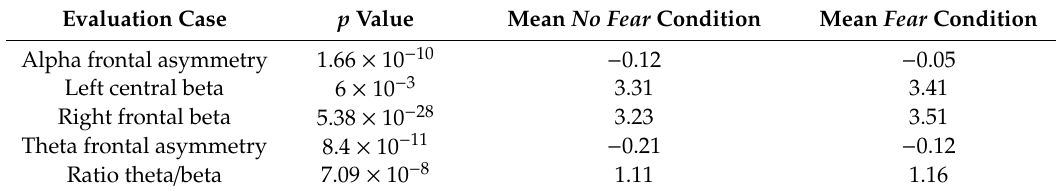
Table 8. p values and means for the two-level fear evaluation condition during the Mann–Whitney